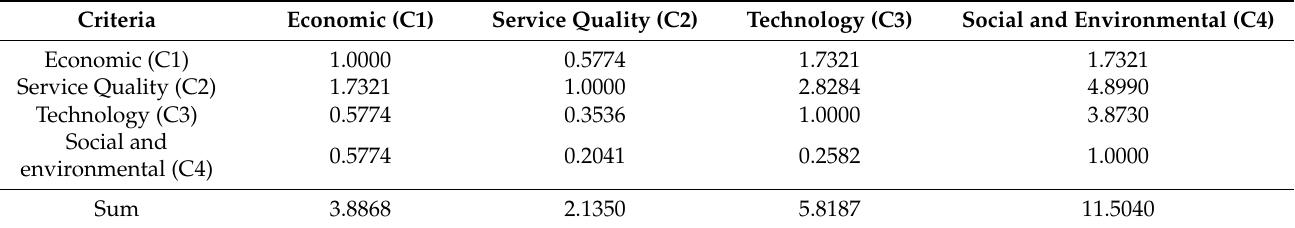
Table 6. The non-fuzzy comparison matrix of FAHP model.